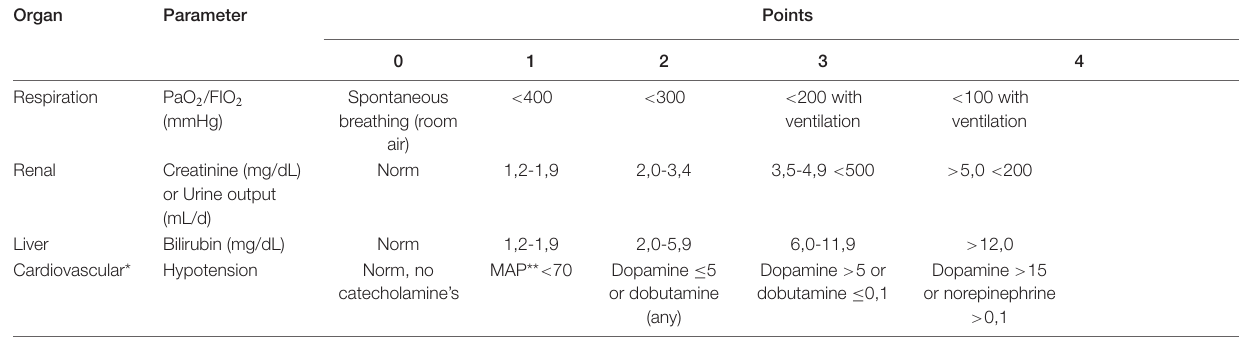
FIGURE 4 | Modified SOFA score